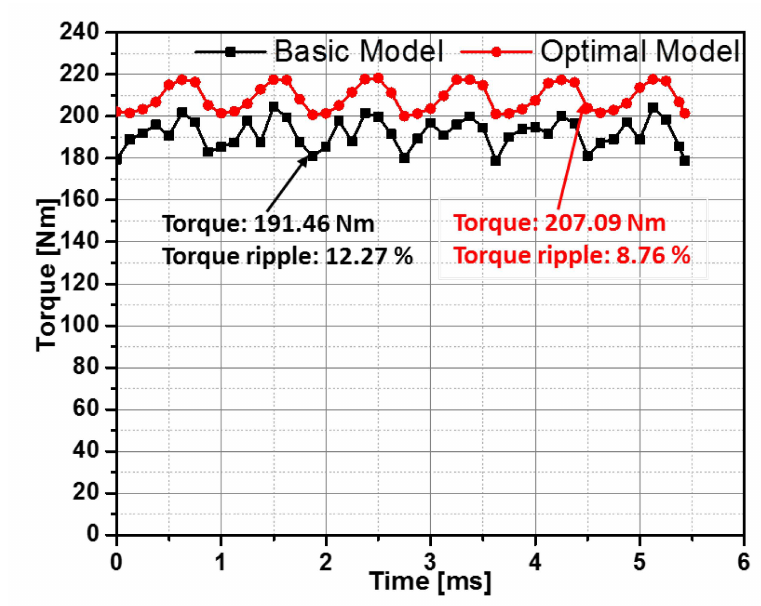
Figure 12. FFT plot of no-load back EMF comparison.